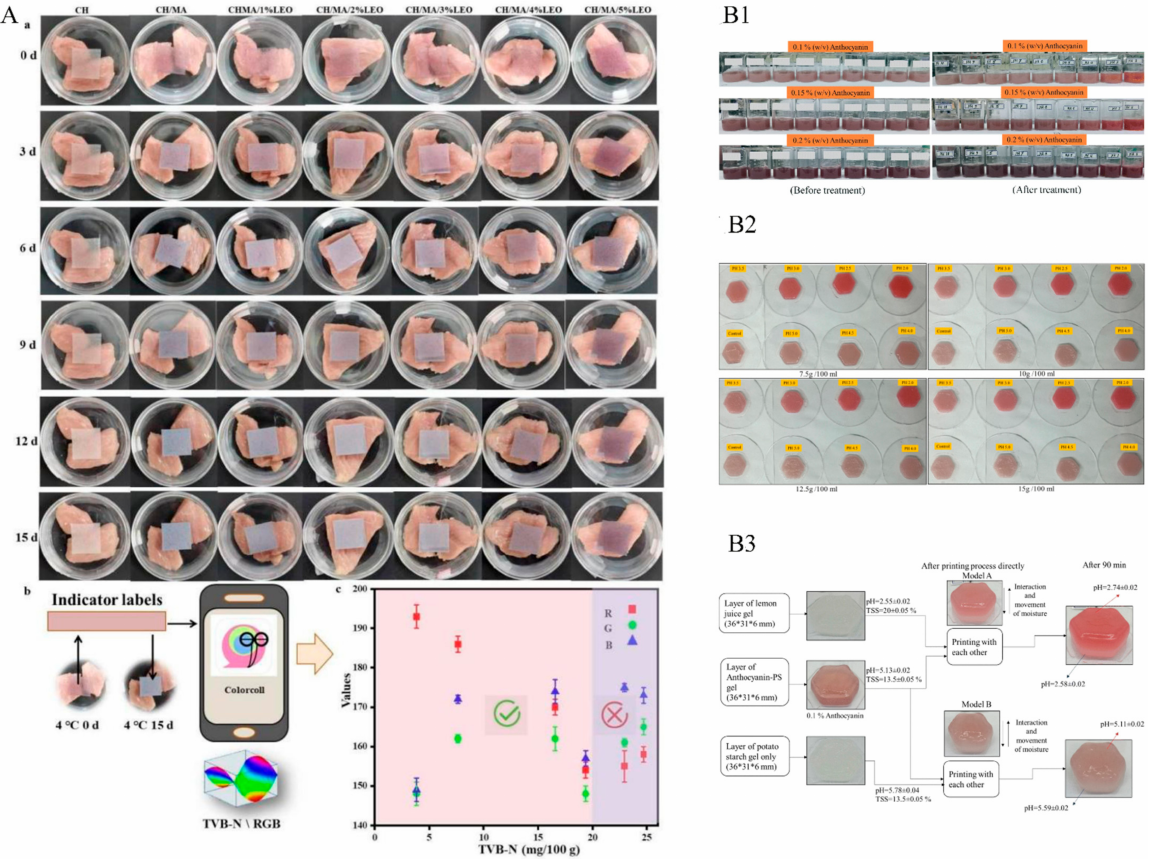
Figure 7. The application of 3D printing in intelligent packaging. ( A ) The 3D printing of MA as a bioindicator film for dyes [37]. ( a ) Pictures of the indicator film stored at 4 ◦ C; ( b ) schematic diagram of the method for assessing meat quality; ( c ) TVB-N results and RGB data for assessing the freshness of pork. ( B ) Principle of applying anthocyanin-P ◦ CS gels for the 3D printing of intelligent food packaging indicators [38]; ( B1 ) color of anthocyanin–PS gels before and after treatment (pH 2–10); ( B2 ) anthocyanin–PS gels color change (pH 2 to 5 and PS 12.5–15%); ( B3 ) design of the 3D-printed